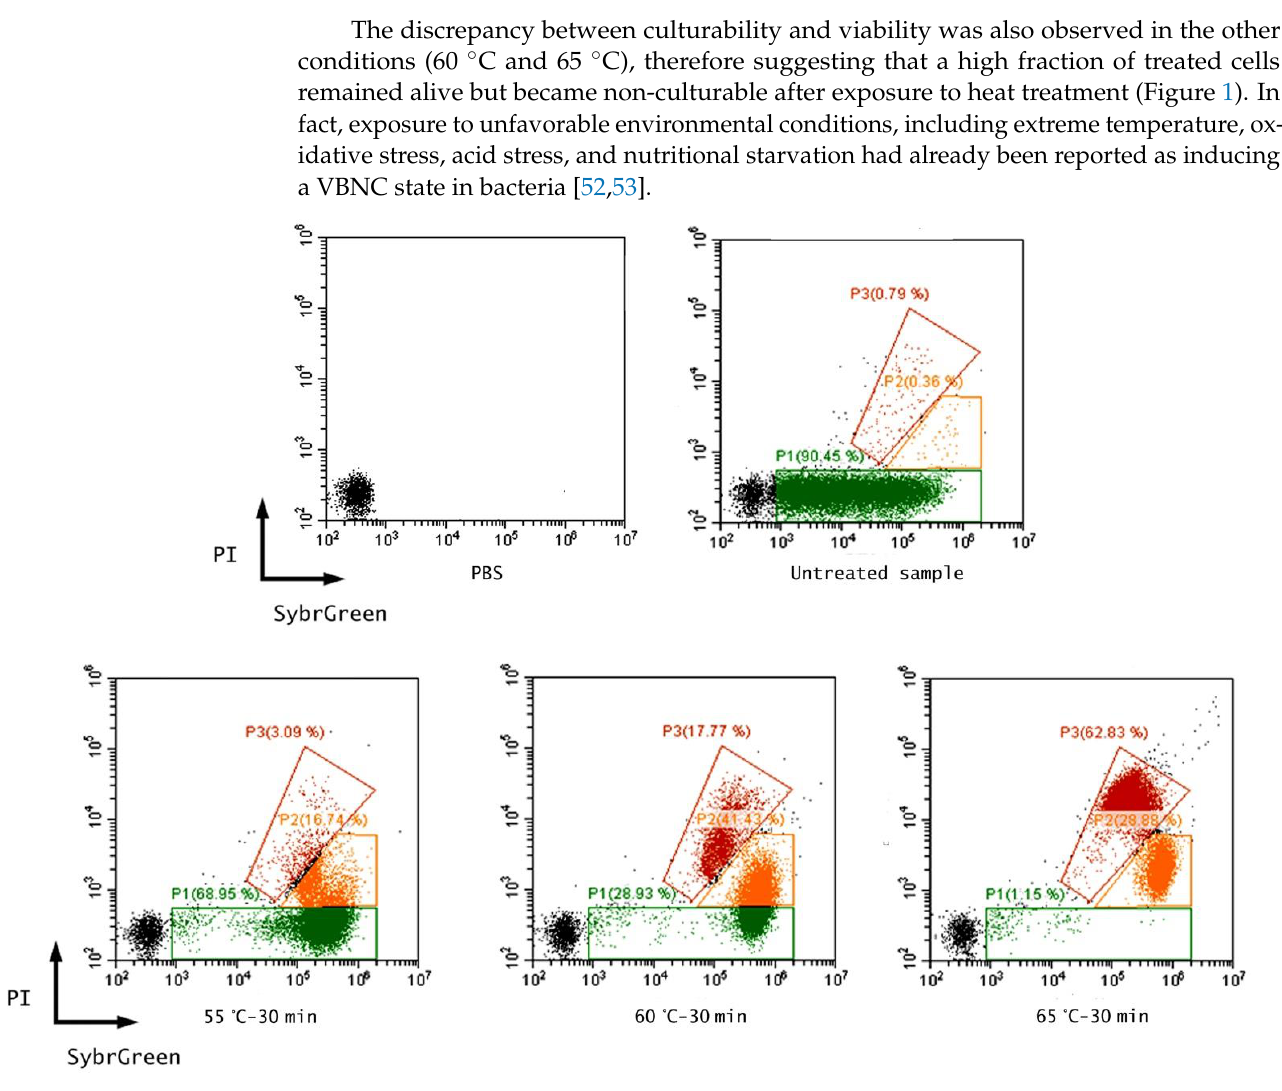
Figure 1. FCM dot plots obtained with a sample of PBS, PBS inoculated with E. coli ATCC 25922 (untreated sample), PBS inoculated with E. coli ATCC 25922 and treated at 55 ◦ C, 60 ◦ C, and 65 ◦ C for (untreated sample), PBS inoculated with E. coli ATCC 25922 and treated at 55 °C, 60 °C, and 65 °C 30 for 30 min.